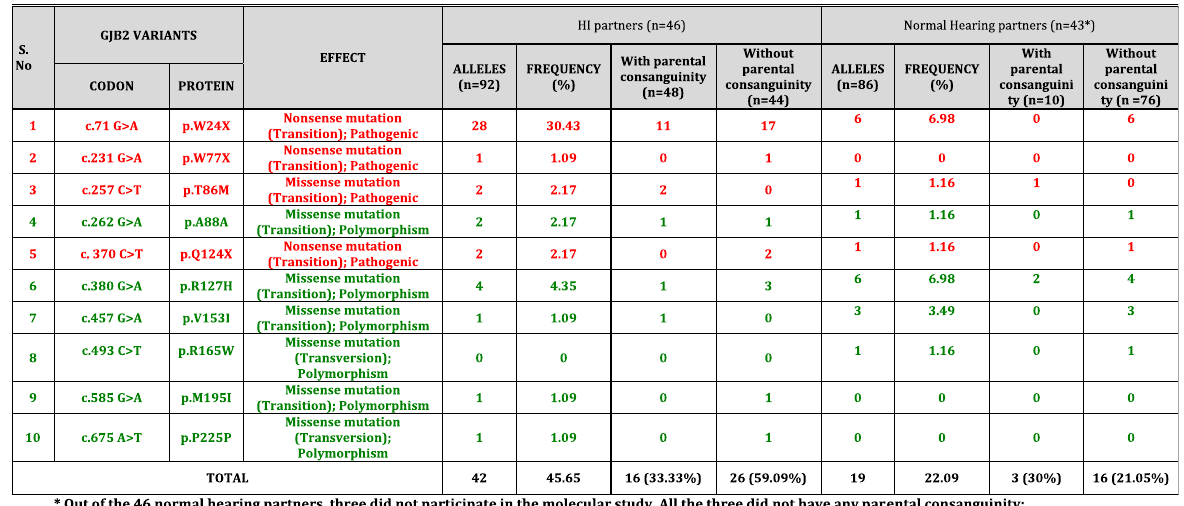
Table 6 Summary of pathogenic mutations/ variants in the GJB2 gene observed among the HI and Normal hearing partners of 46